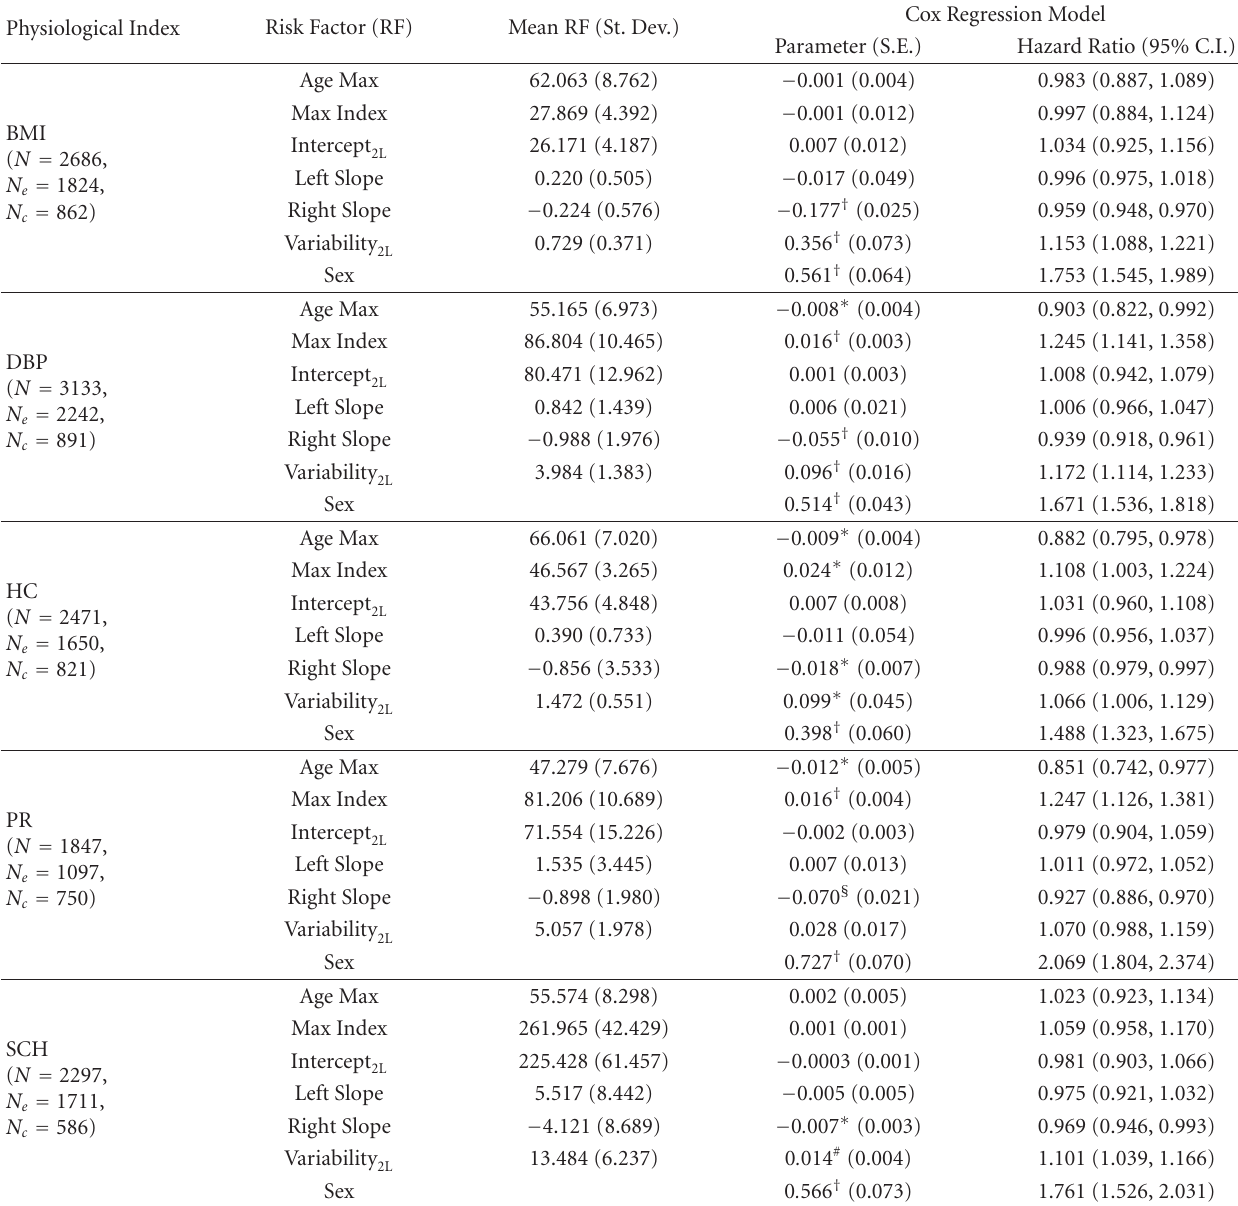
Table 3: E ff ect of “dynamic” risk factors calculated from individual trajectories of physiological indices with nonmonotonic patterns on mortality risk in the Framingham Heart Study (original cohort) estimated by the Cox proportional hazards